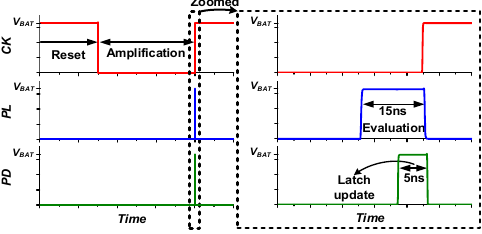
Figure 9. Voltage peak detector timing waveform.